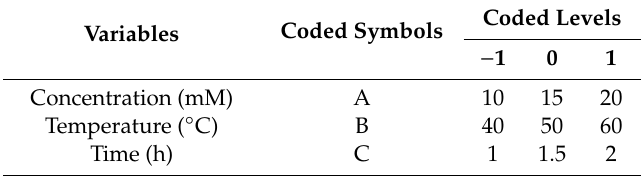
Table 2. Experiments design for response surface methodology